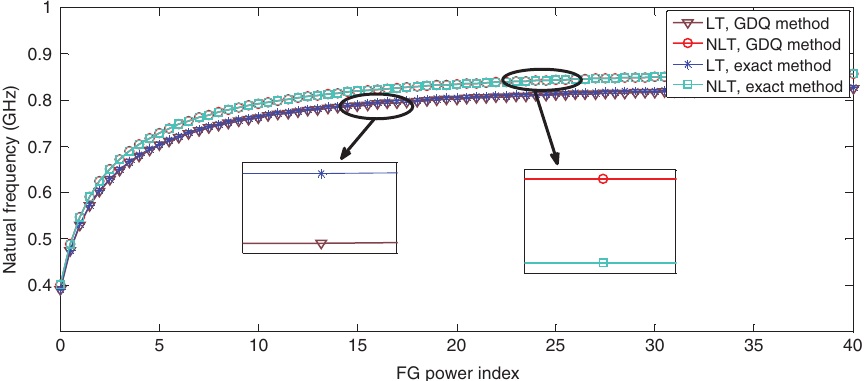
= 14 μ m, l = l /2, n = 1, m c m